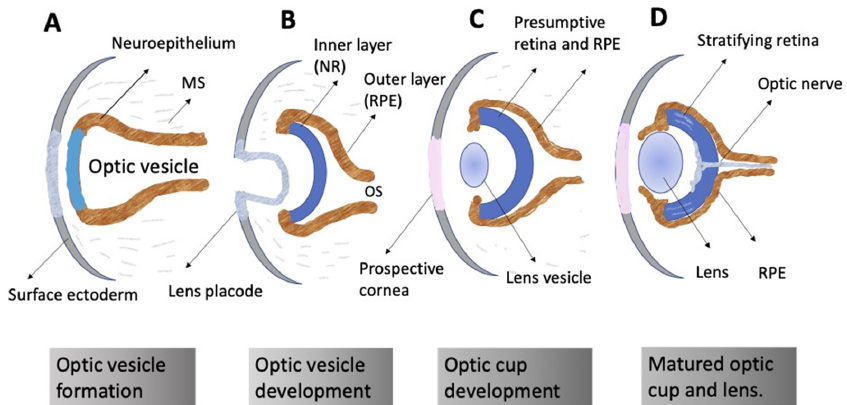
Figure 2. Schematic representation of vertebrate eye development. ( A ) Formation of the optic vesicle. ( B ) Specification of the NR (inner layer), RPE (outer layer), and optic stalk (OS) domains within the optic vesicle. Formation of the lens placode from the surface ectoderm. ( C ) Formation of the optic cup and the lens vesicle. ( D ) Organization of the formed eye. Neural retina stratification; growth of the optic nerve. MS: mesenchyme.